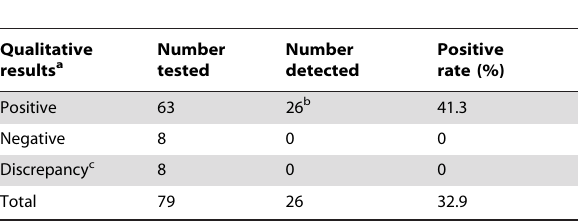
Table 3. C. pneumoniae loads in CSF specimens determined by TaqMan real-time quantitation.